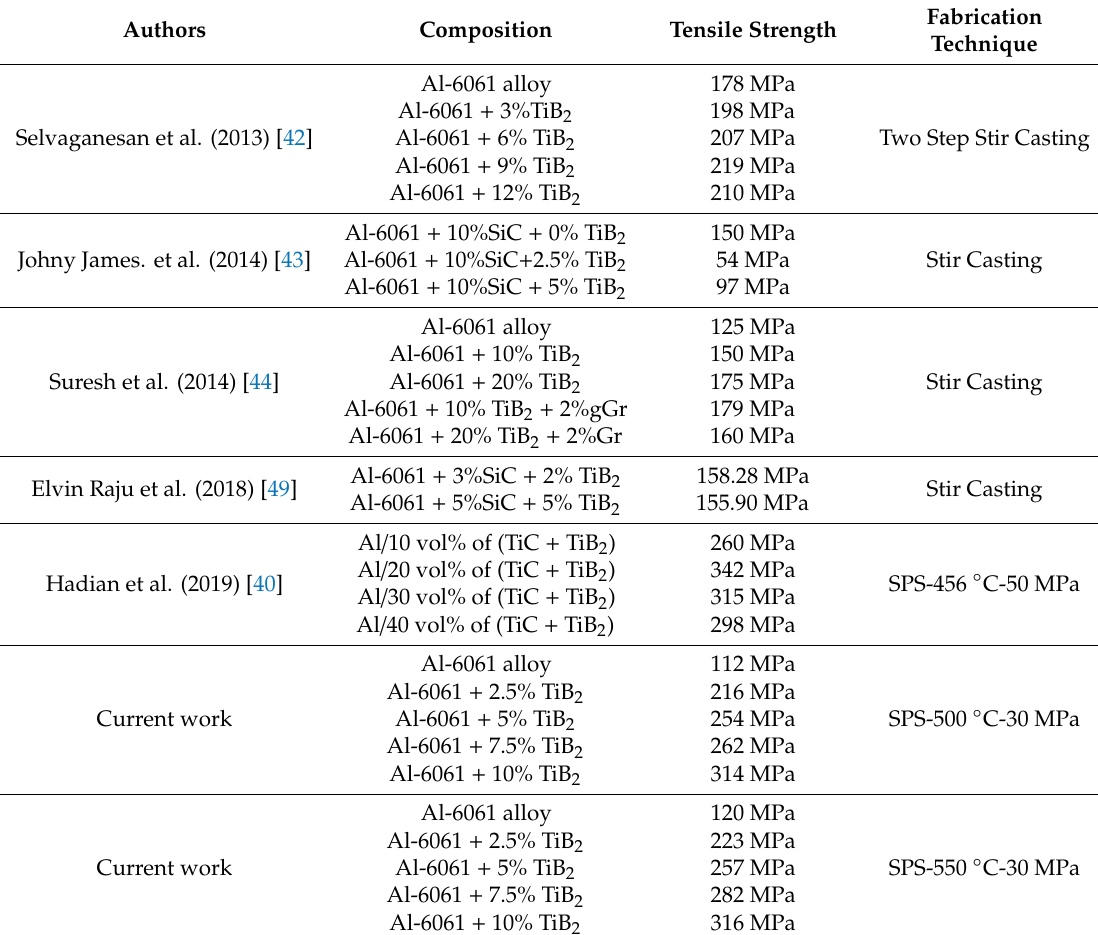
Table 4. Comparison of the tensile strength of Aluminium Metal Matrix Composite Works with the present